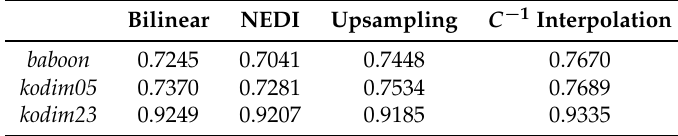
Table 2. Mean structural similarity (MSSIM)